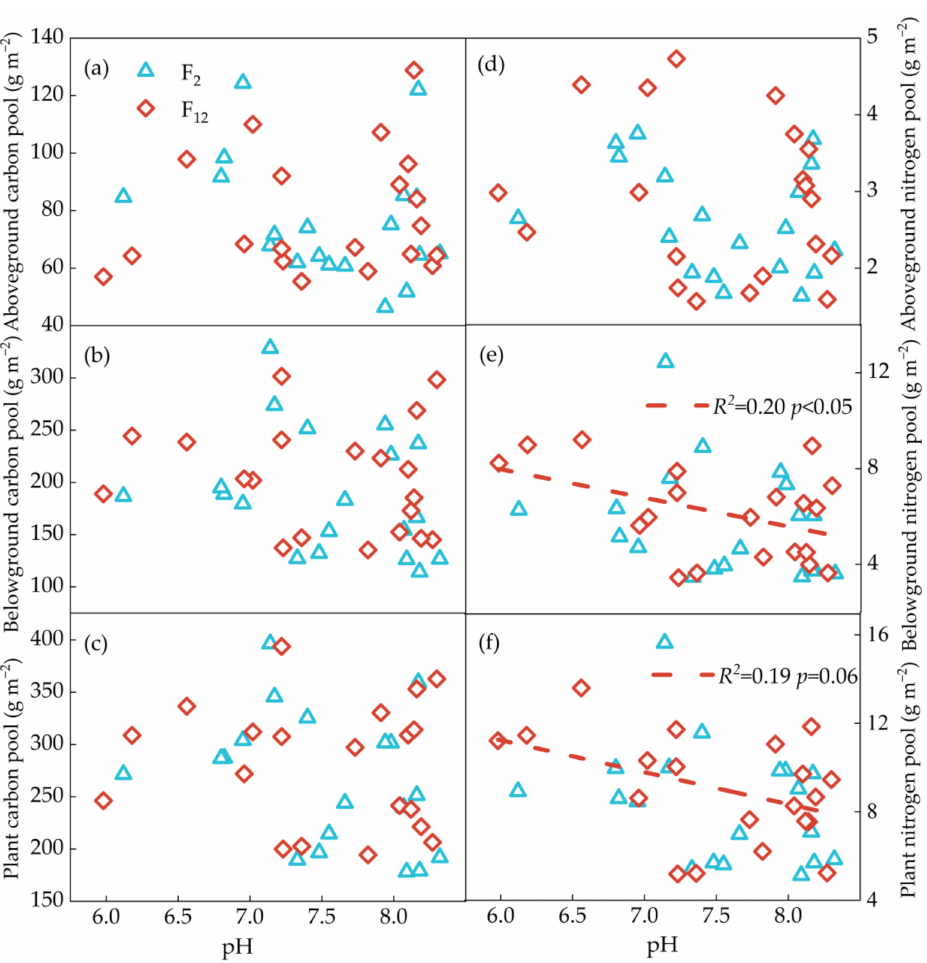
Figure 7. The relationships between soil moisture, pH and PAGC ( a ), PBGC ( b ), PC ( c ), PAGN ( d ), plant PBGN ( e ) and PN ( f ). Blue triangles with solid lines indicate 2 N additions yr − 1 (F 2 ). The red quadrilateral and dotted line indicate once a month (F 12